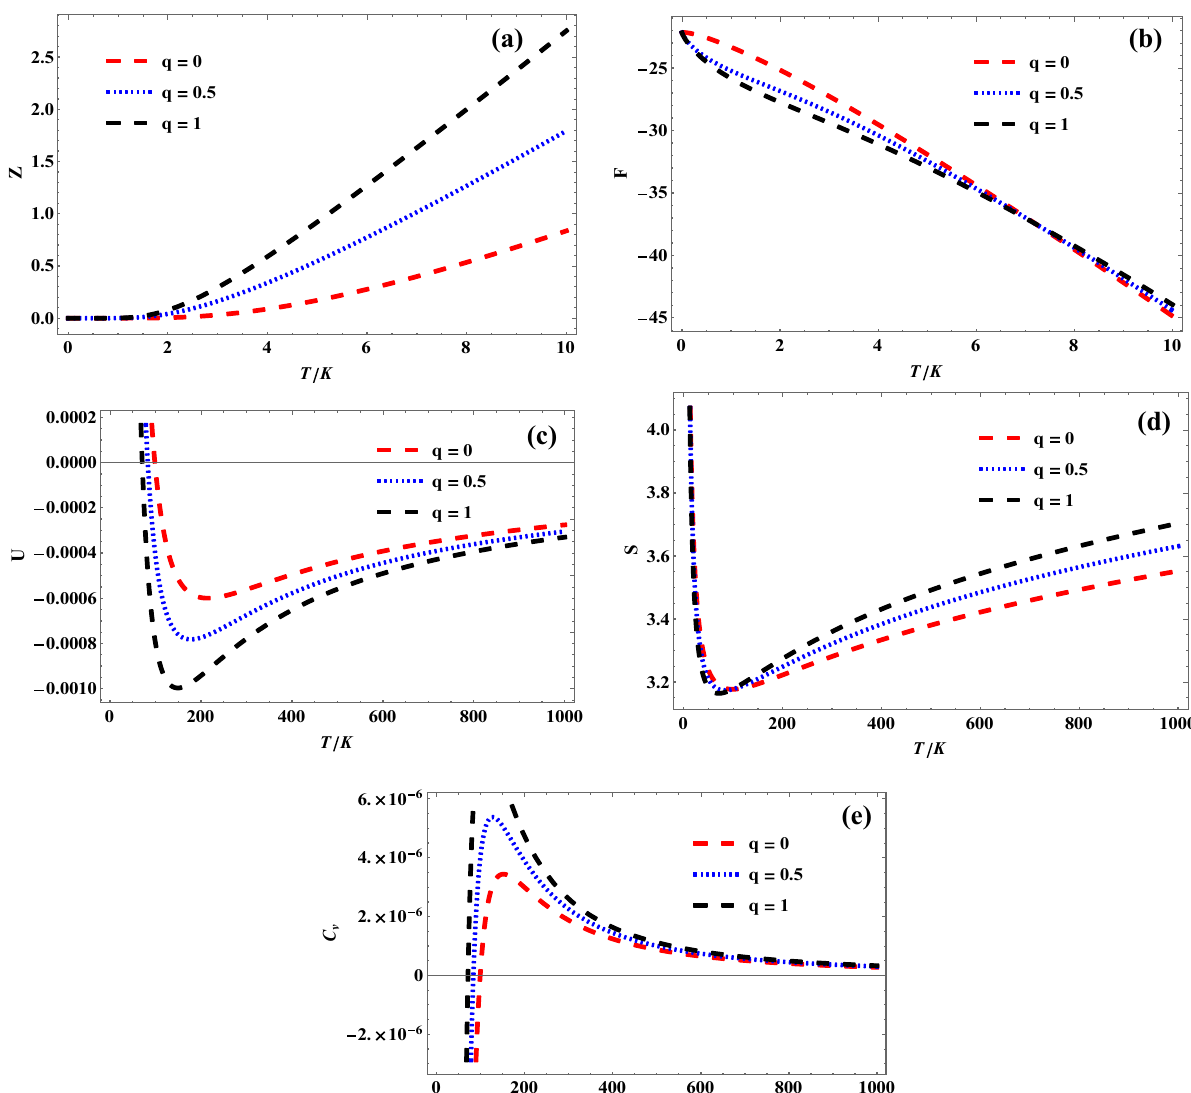
Figure 3. ( a ) Variation of partition function of quantum pseudoharmonic oscillator with temperature for selected q -values with κ = 0. ( b ) Variation of free energy of quantum pseudoharmonic oscillator with temperature for selected q -values with κ = 0. ( c ) Variation of internal energy of quantum pseudoharmonic oscillator with temperature for selected q -values with κ = 0. ( d ) Variation of entropy of quantum pseudoharmonic oscillator with temperature for selected q -values with κ = 0. ( e ) Variation of specific heat capacity of quantum pseudoharmonic oscillator with temperature for selected q -values with κ =